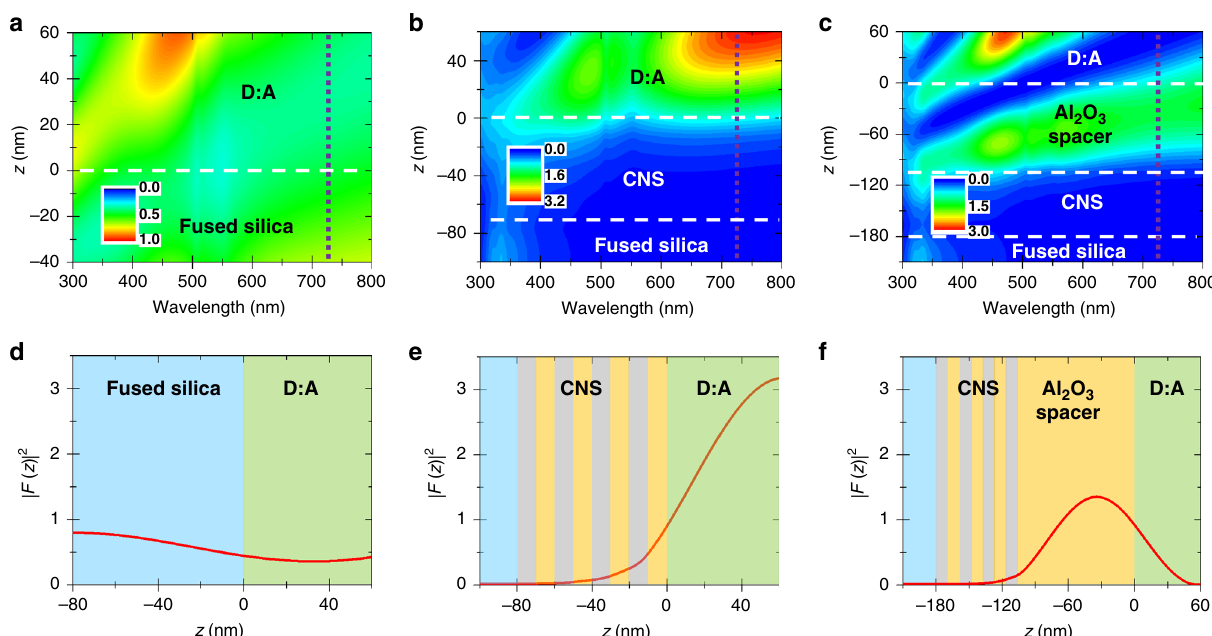
Fig. 3 Optical modulation induced by the substrate structure. a – c False-color plot of the optical fi eld intensity, | F 2 |, as a function of incident wavelengths and position within the sample. d – f Optical- fi eld intensity distribution within the sample corresponding to a cross section at 725 nm of a – c with the background colors representing the sample composition. Fused silica substrate ( a , d ), 4p-composite nanostructure (CNS) with an Al 2 O 3 top layer of 10 nm ( b , e ), and 100 nm ( c , f ), respectively, and Donor:Acceptor (D:A) thin fi lm. The horizontal lines materialize the different layers of